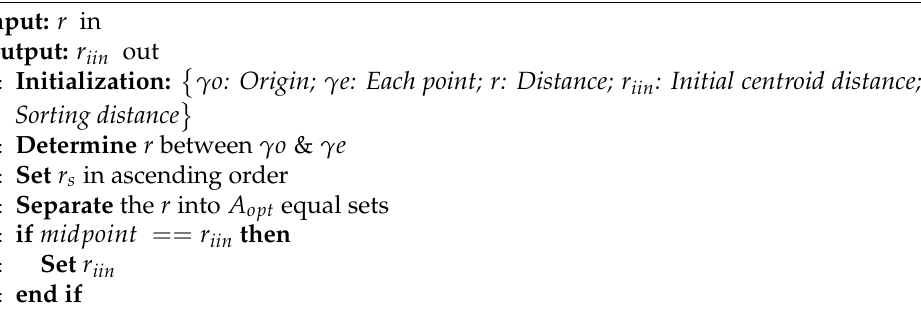
Algorithm 1 Optimized distance determination from sensor node to actuator.